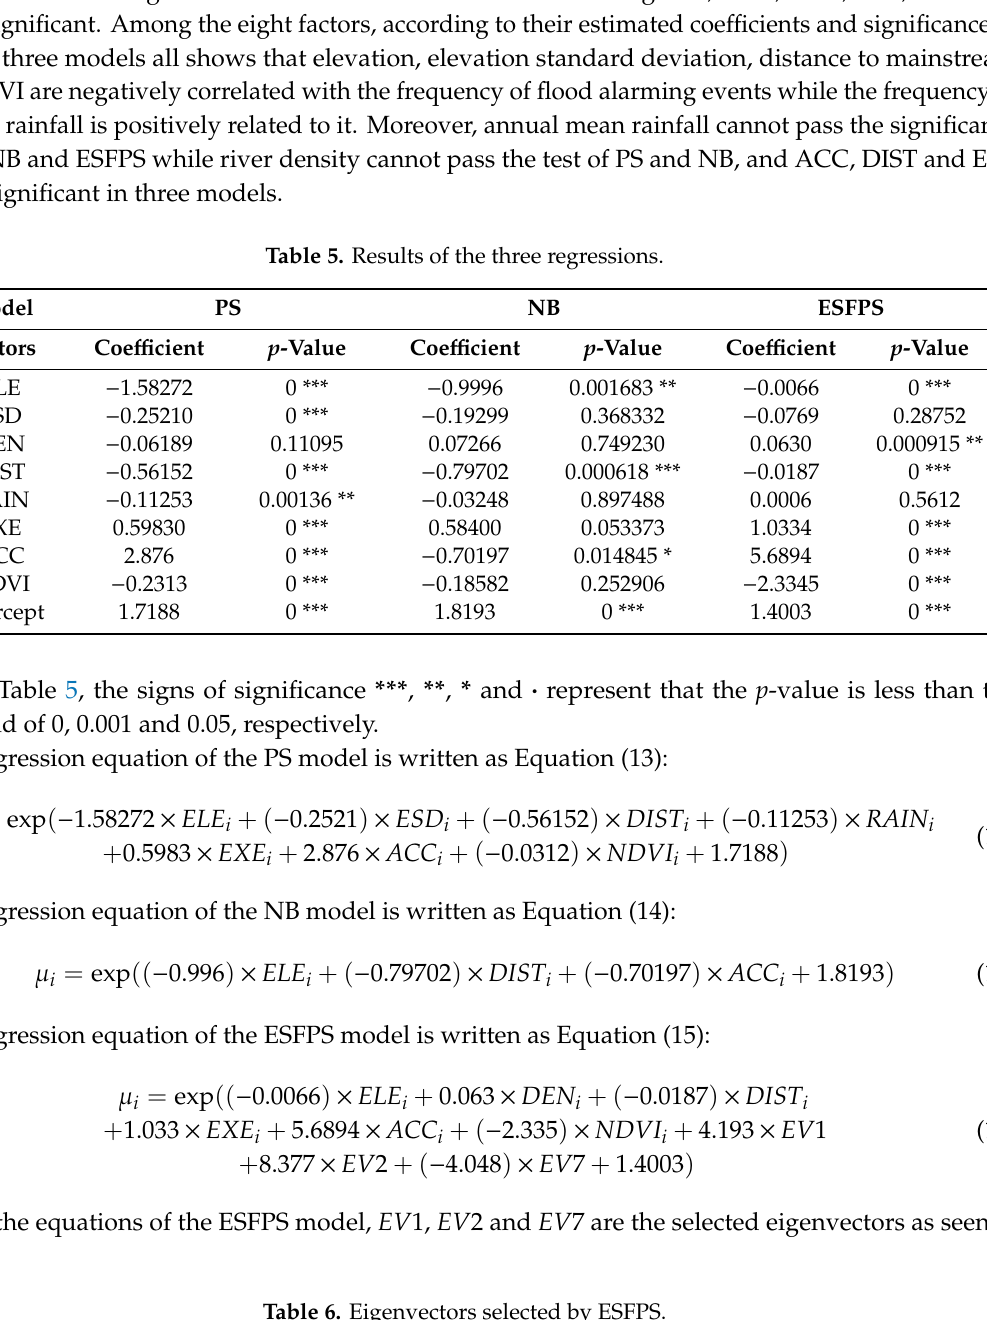
Table 6. Eigenvectors selected by